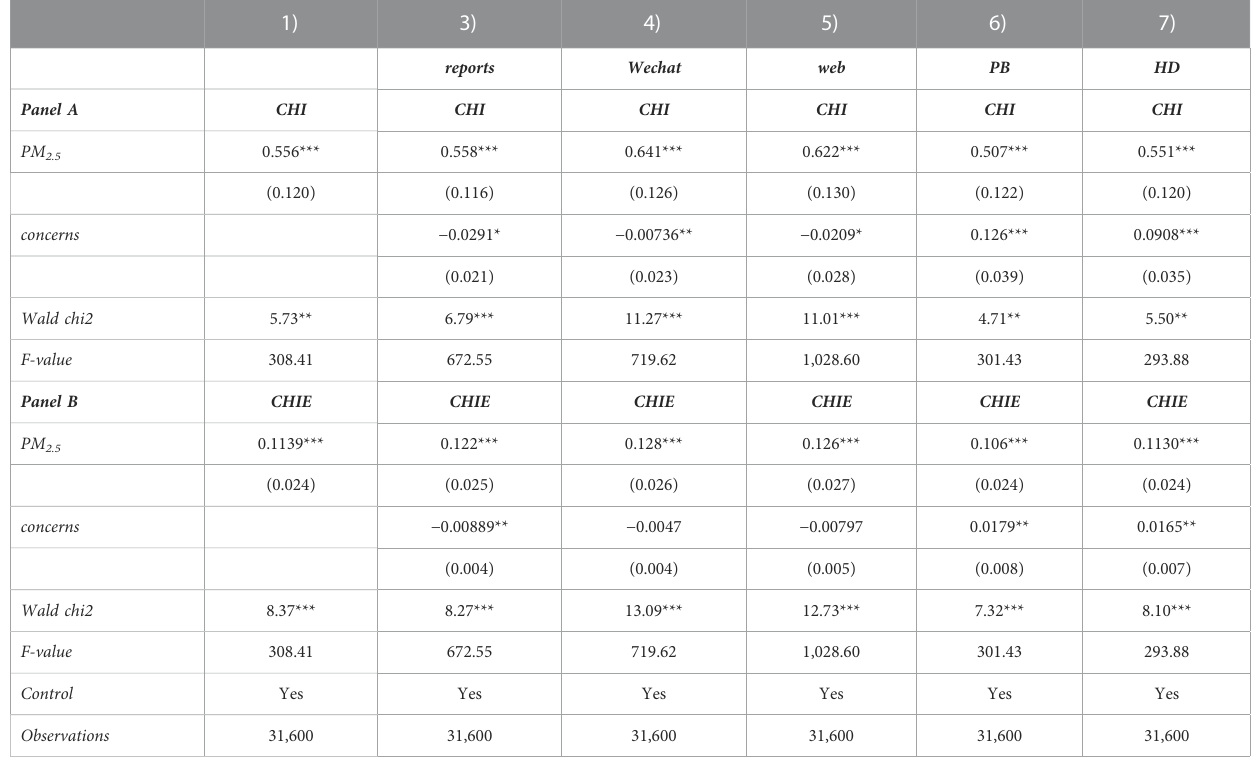
TABLE 7 Regression results of excluding the migrated